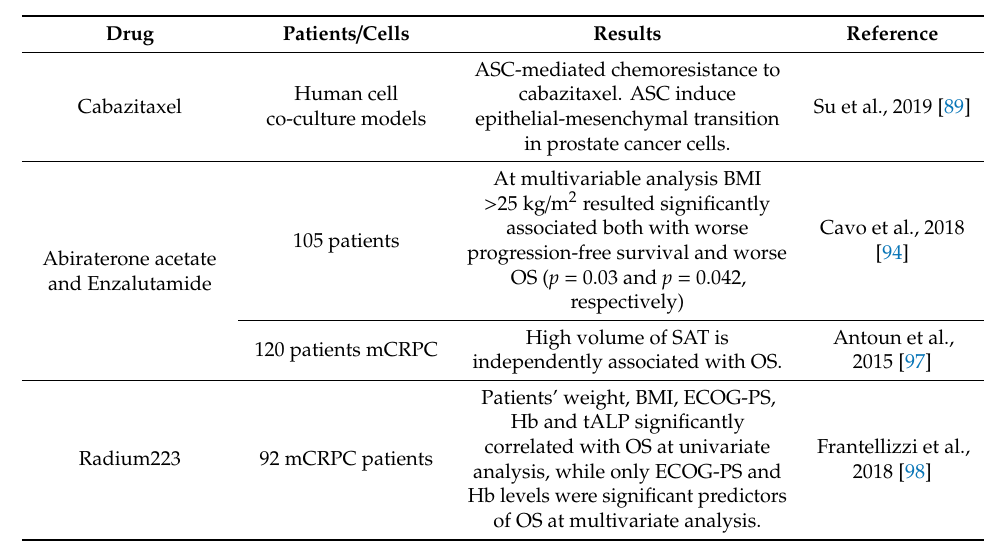
Drug Patients / Cells Results Reference ASC-mediated chemoresistance to cabazitaxel. ASC induce Human cell Cabazitaxel epithelial-mesenchymal transition co-culture models in prostate cancer cells. At multivariable analysis BMI > 25 kg / m 2 resulted significantly associated both with worse 105 patients progression-free survival and worse Abiraterone acetate OS ( p = 0.03 and p = 0.042, and Enzalutamide respectively) High volume of SAT is 120 patients mCRPC independently associated with OS. Patients’ weight, BMI, ECOG-PS, Hb and tALP significantly correlated with OS at univariate Radium223 92 mCRPC patients analysis, while only ECOG-PS and Hb levels were significant predictors of OS at multivariate